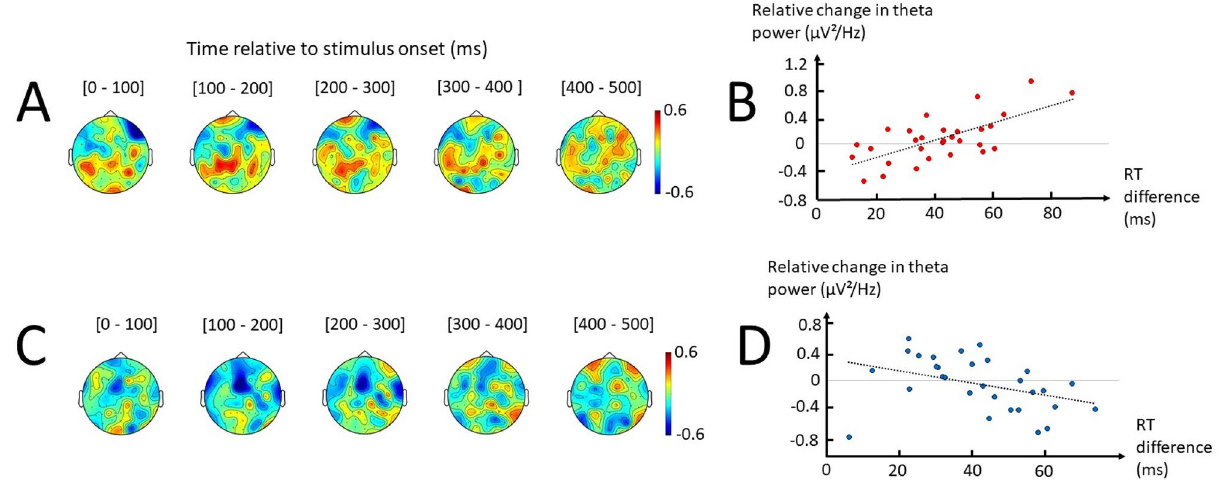
Figure 4. Correlations between theta power and RT difference associated with Difficulty in Instructed and Free. ( A ) Topographical representation of Spearman’s coefficients of the correlation between the difference in baseline-normalized theta power and RT in Instructed as a function of Difficulty (Instructed Hard–Instructed Easy) performed on each electrode separately. Each topographical plot represents the average Spearman’s coefficient in 100-ms windows defined according to target onset. Black dots indicate the electrodes with the highest absolute coefficient, specifically represented in B . ( B ) Linear fit between the difference in baseline- normalized theta power at parietal electrodes (CPz, CP1, CP3) and the difference in RT in Instructed as a function of Difficulty. ( C ) Topographical representation of Spearman’s coefficients of the correlation between the difference in baseline-normalized theta power and RT in Free as a function of Difficulty (Free Hard–Free Easy) performed on each electrode separately. Black dots indicate the electrodes with the highest absolute coefficient, specifically represented in D . ( D ) Linear fit between the difference in baseline-normalized theta power at midfrontal/left premotor electrodes (Fz, F1, FC1) and the difference in RT in Free as a function of